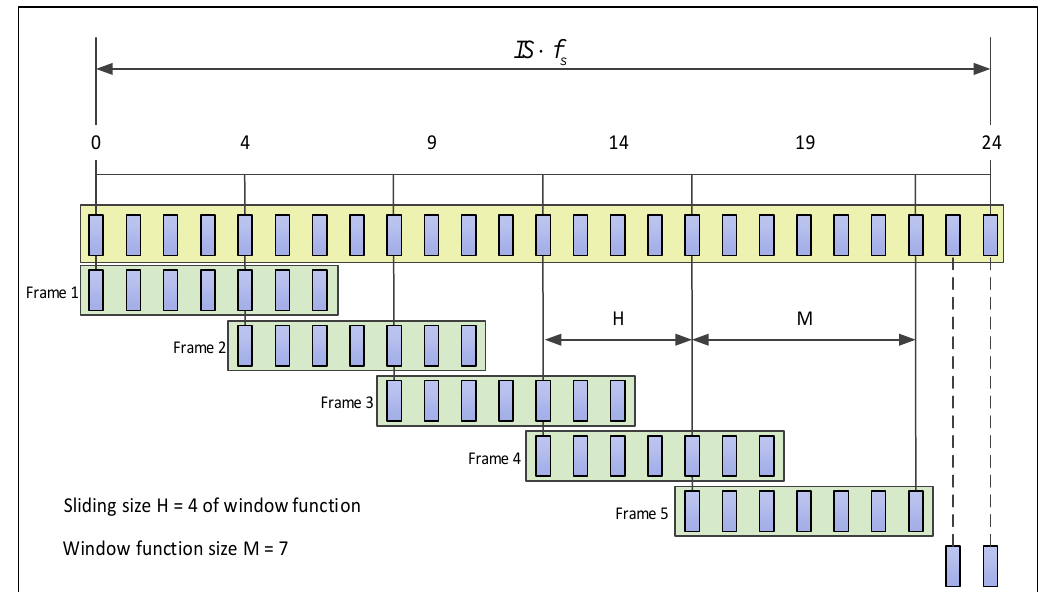
Figure 5. Calculation of the total frames of noise data.